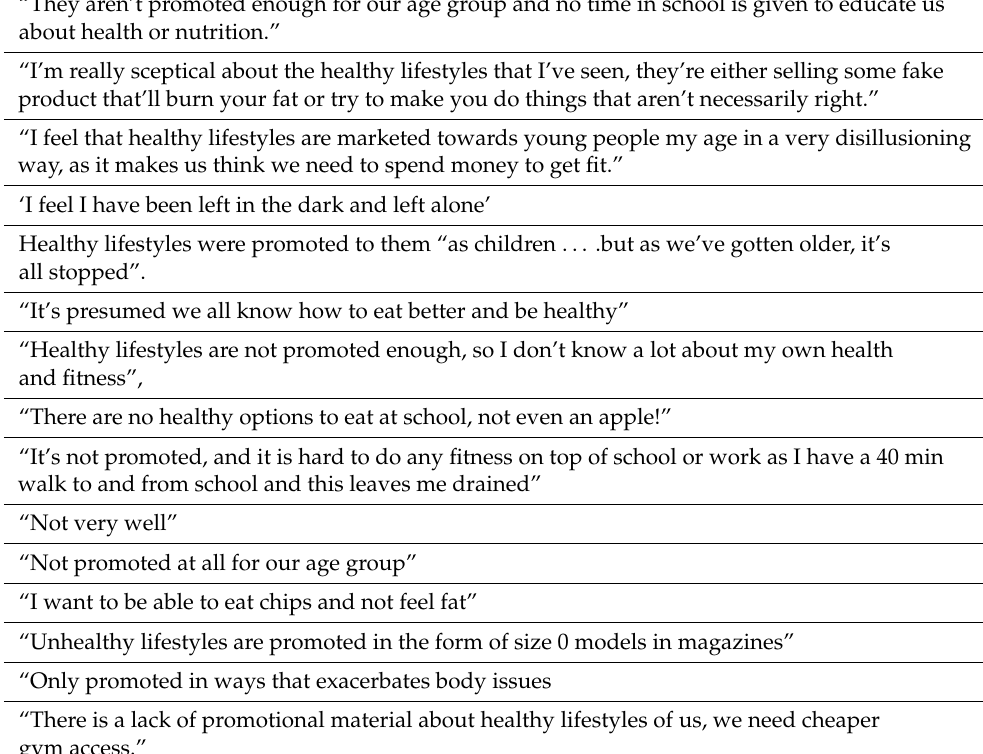
Table 2. Negative responses to healthy lifestyle